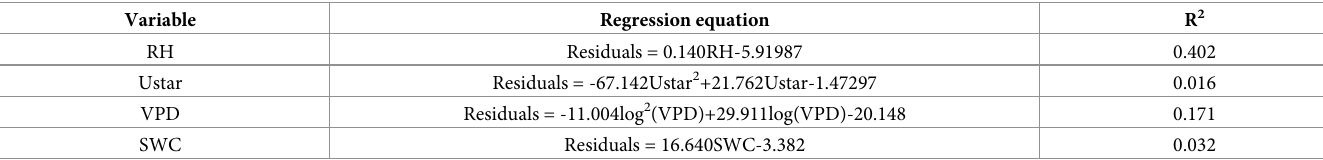
Table 2. Relationships between the residuals from the regression of GPP-R n and environmental variables at the daily time scale. Variable Regression equation